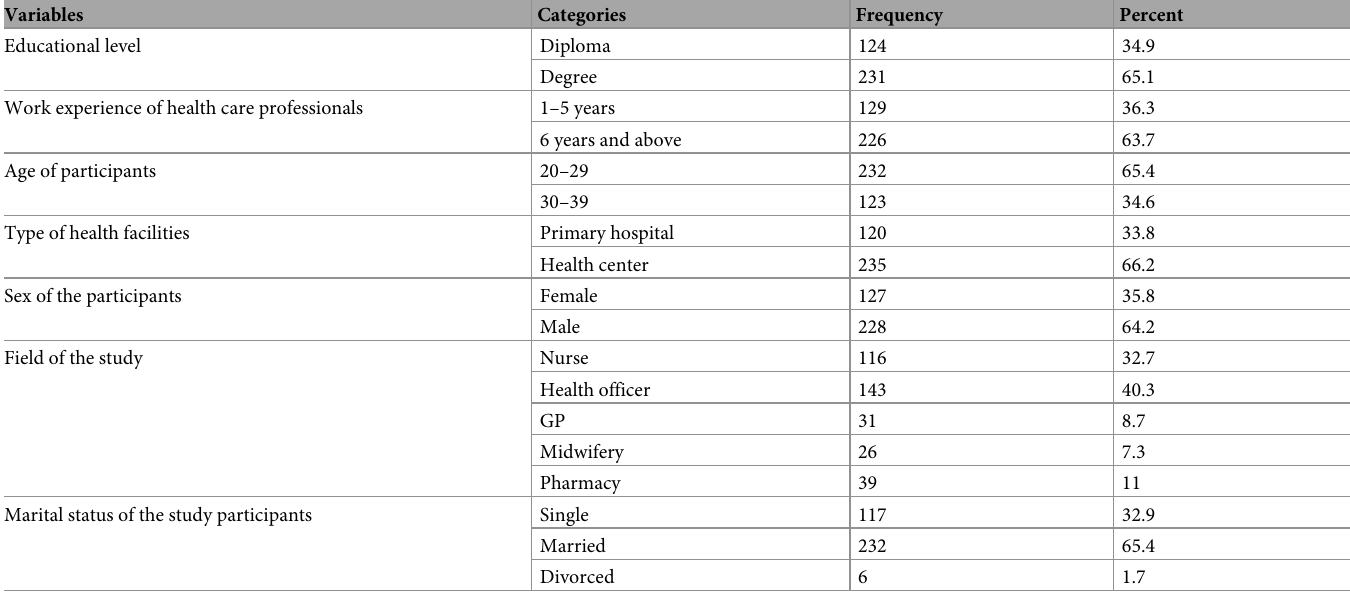
Table 1. Socio demographic characteristics of health care professionals in selected primary health care unit in Hadiya Zone, Southern Ethiopia, April, 2021 (n = 335).